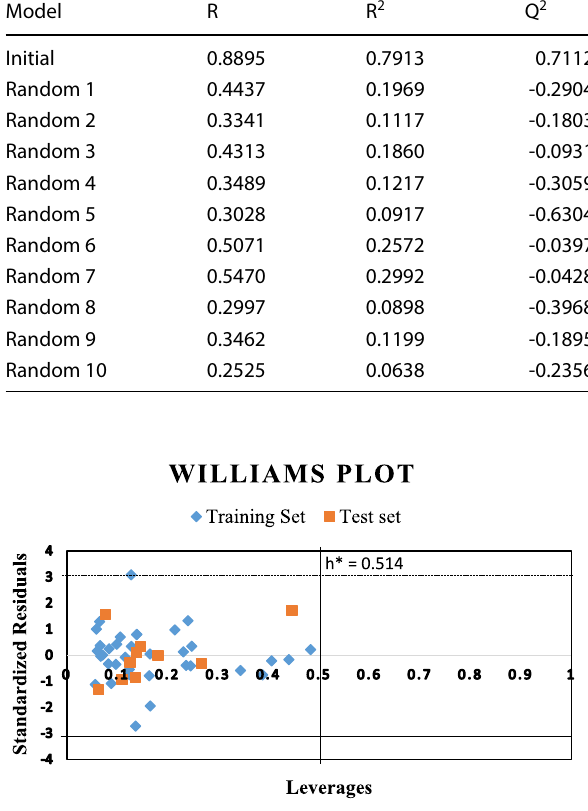
Table 5 Results of Y-randomization performed Model